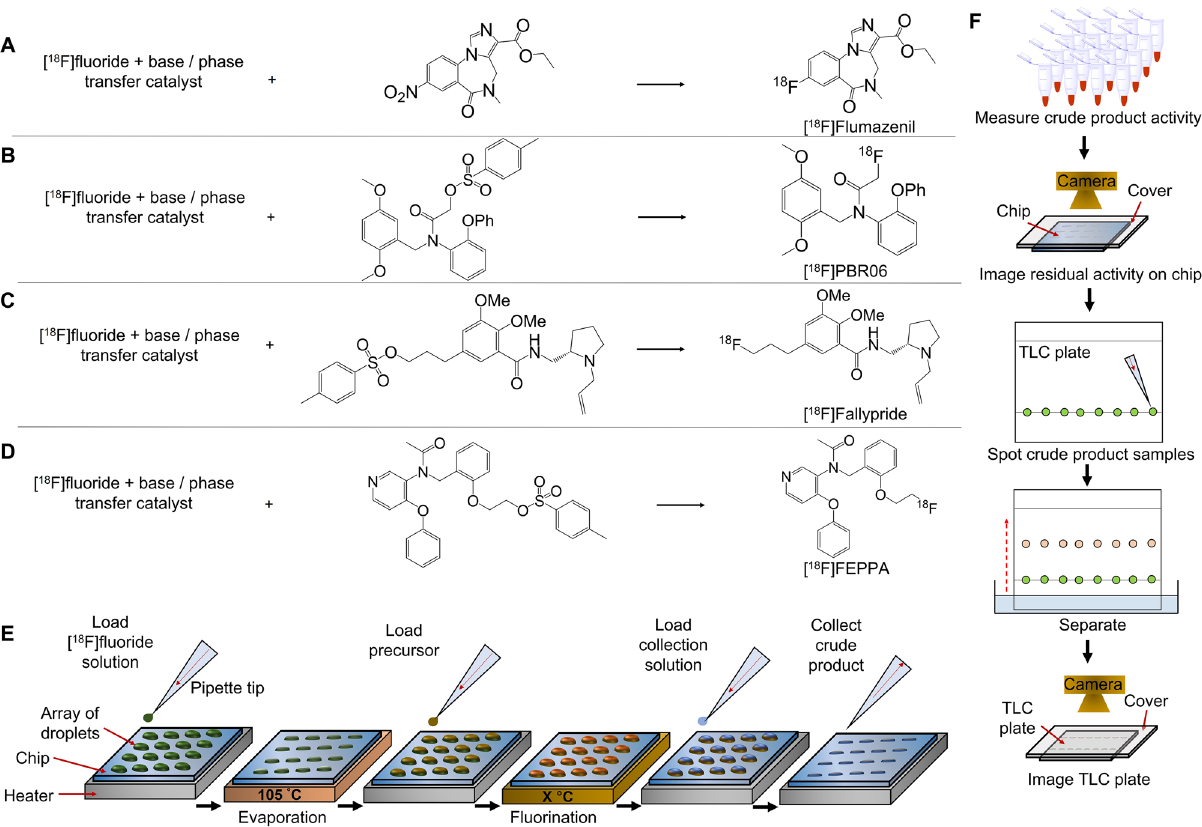
Figure 2. Optimization process. ( A ) Scheme for the radiosynthesis of [ 18 F]Flumazenil. ( B ) Synthesis of [ 18 F]PBR06. ( C ) Synthesis of [ 18 F]Fallypride. ( D ) Synthesis of [ 18 F]FEPPA. ( E ) Experimental procedure for performing parallel radiosyntheses using a (4 × 4) multi-reaction microdroplet chip. Concentrations, solvents, and volumes can be varied from site to site, and temperature and heating time can be varied from chip to